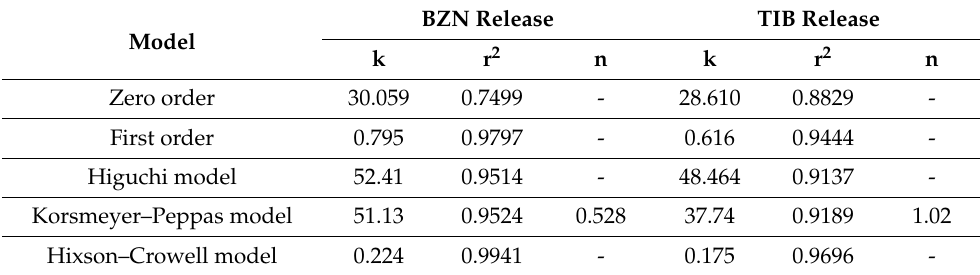
Table 5. In vitro release kinetics of BZN and TIB from the optimized (F9) formulation.